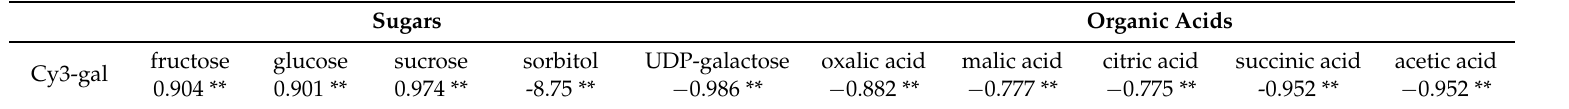
Figure 3. HPLC separation and concentration changes of soluble sugars in “Starkrimson” apple flesh during ripening period. ( A ) “Starkrimson” apple peel monitored by refractive index (RI) detector. Peaks: 1 UDP ‐ galactose; 2 fructose; 3 sucrose; 4 glucose; 5 sorbitol; b, c and d values are means ± SE ( n = 4); ( B – F ) concentration and changes of fructose, sucrose, glucose, sorbitol and UDP ‐ galactose in “Starkrimson” apple peel during ripening period. Table 1. Correlation coefficients between cy3 ‐ gal with soluble sugars and organic acids during apple ripening.